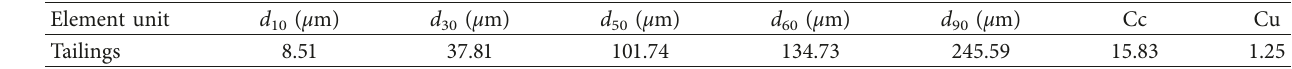
Table 2: Particle size characteristics of tailings.